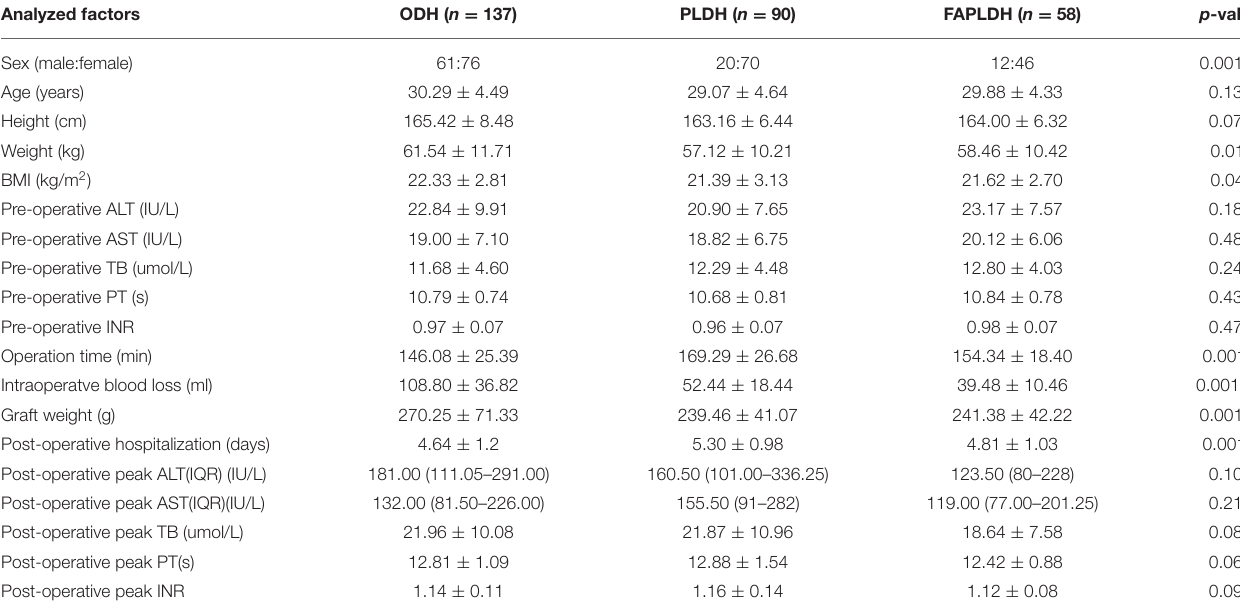
TABLE 1 | Donors’ baseline characteristics and